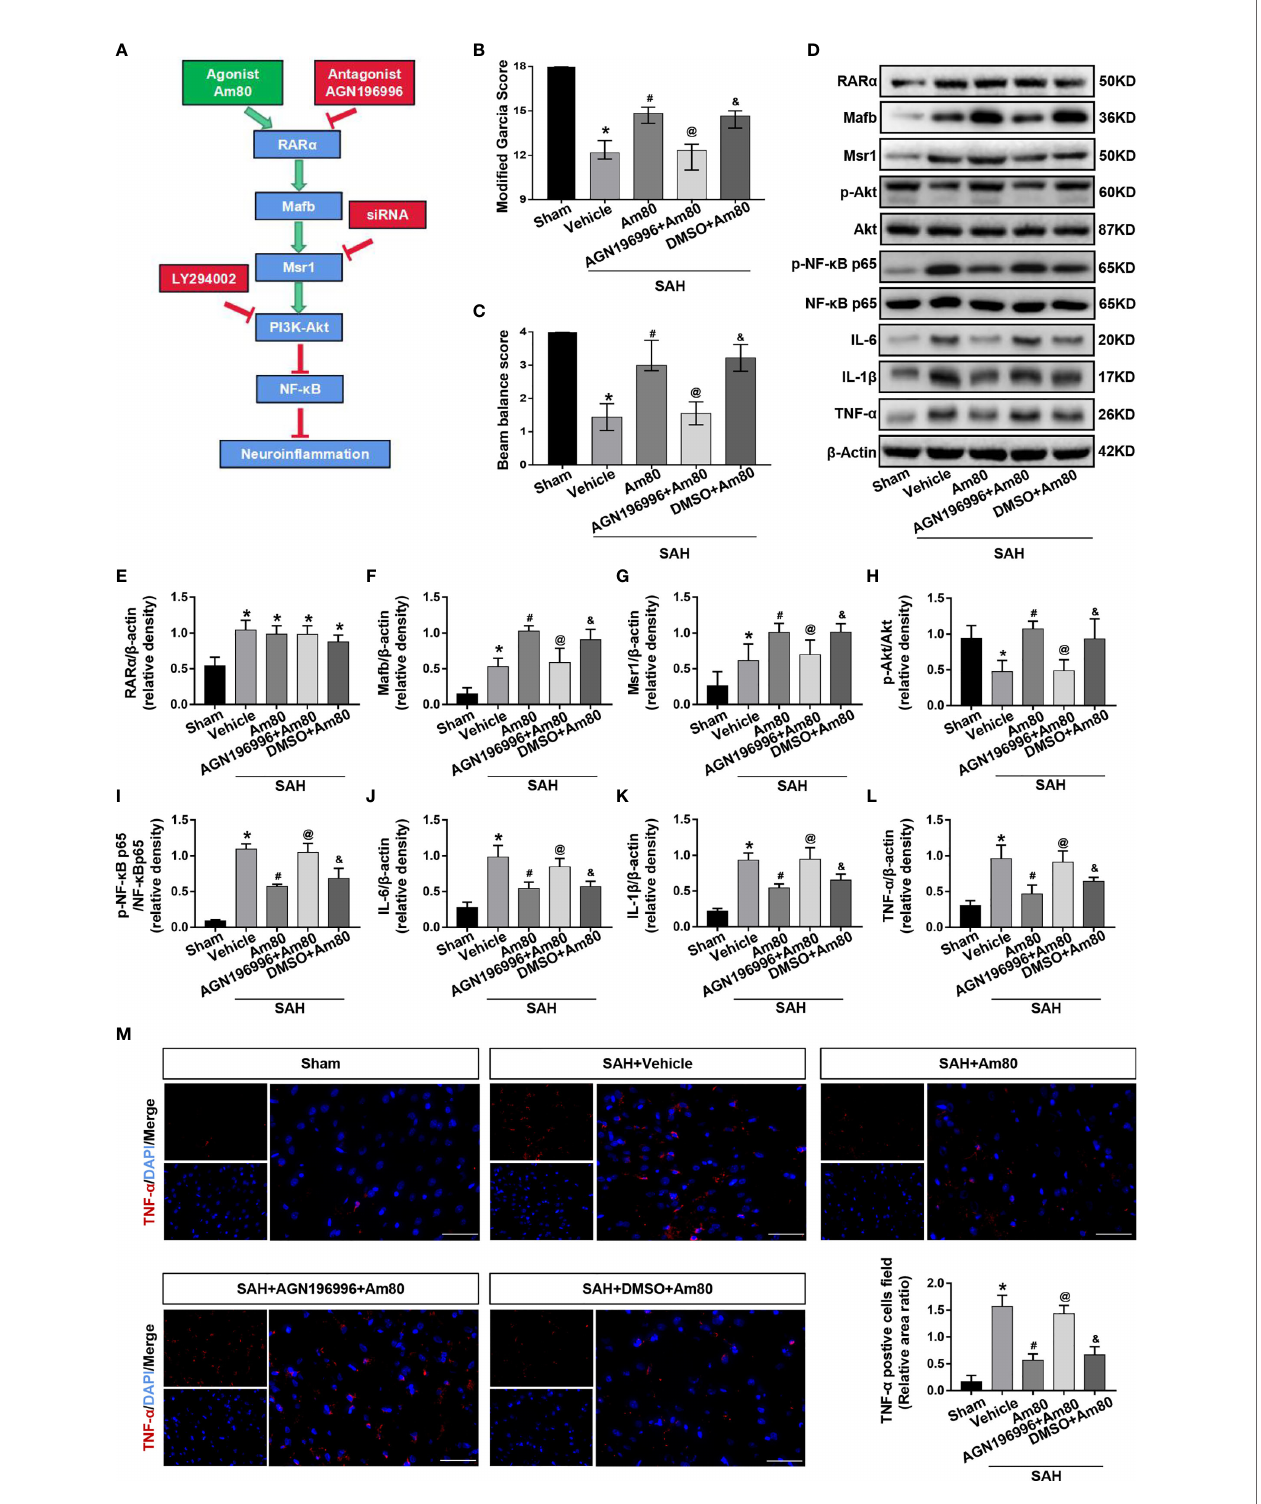
FIGURE 7 | AGN196996 abolished the protective effects of Am80. (A) Schematic diagram of experimental design. (B, C) The neurological score were evaluated at 24 h after SAH. n = 6 per group. (D – L) Western blotting and quantitative analyses of the expression of RAR a , Mafb, Msr1, p-Akt, p-NF-kB, IL-6 , IL-1 b and TNF- a . n = 6 per group. (M) Immuno fl uorescence staining and quantitative analyses of TNF- a -positive cells fi eld ratio. Scale bar=50 m m. n = 3 per group. * P < 0.05 vs sham group; # P < 0.05 vs SAH+vehicle group; @ P < 0.05 vs SAH+Am80 group; & P < 0.05 vs SAH+AGN196996+Am80